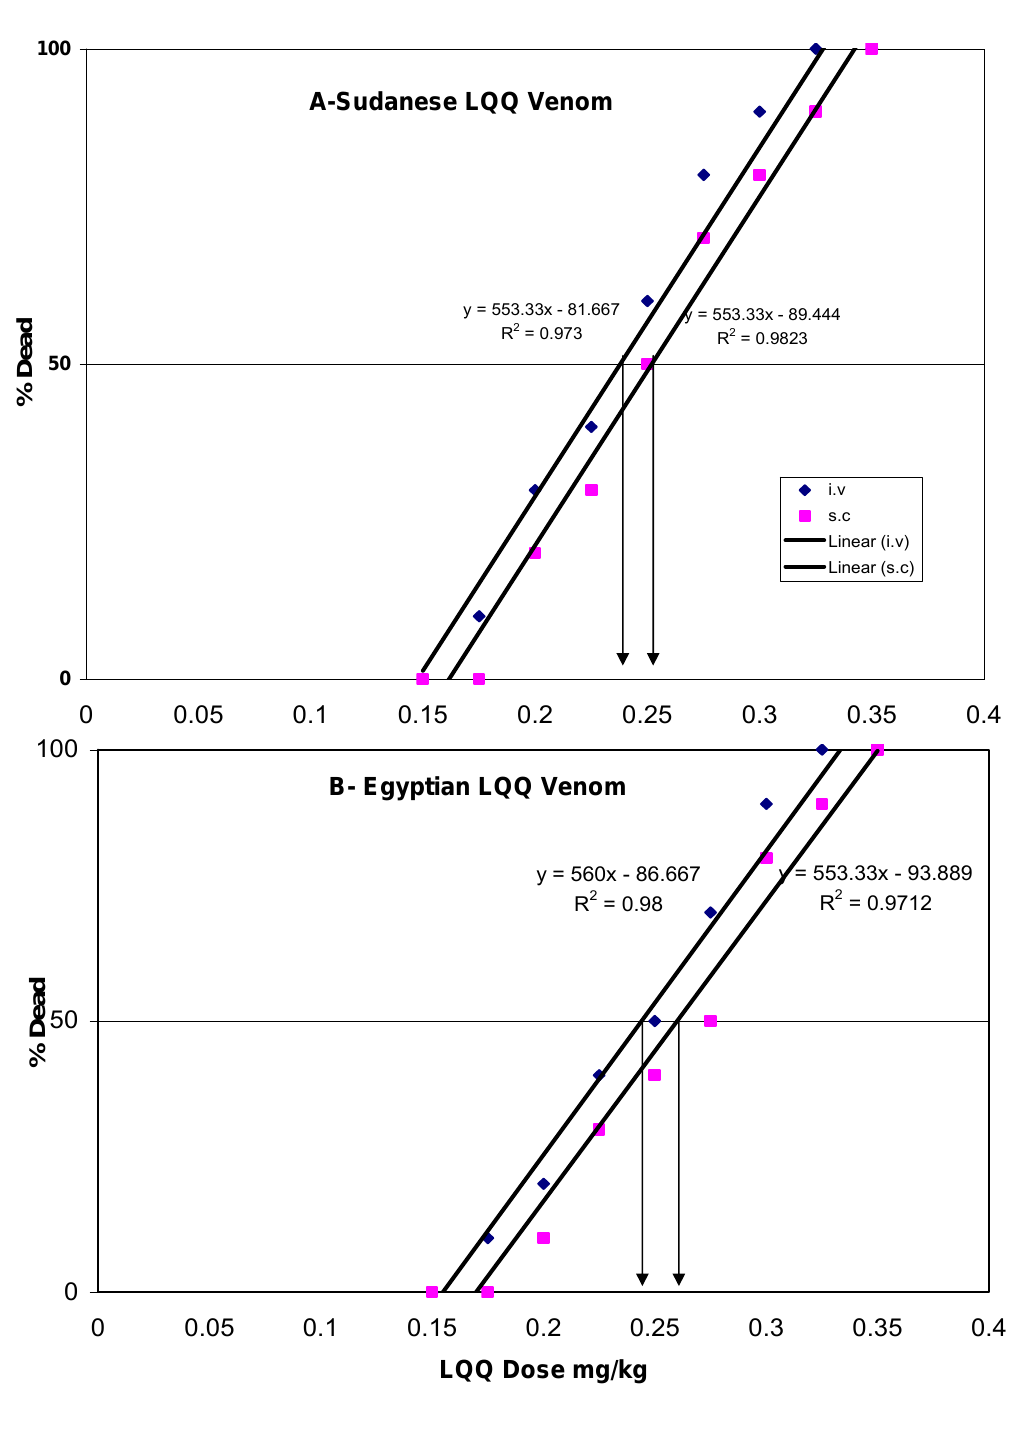
Figure 1: Determination of LD by intravenous (i.v.) and subcutaneous (s.c.) 50 injection of Sudanese (A) and Egyptian (B) Leiurus quinquestriatus venom into mice. - Each group contained 10